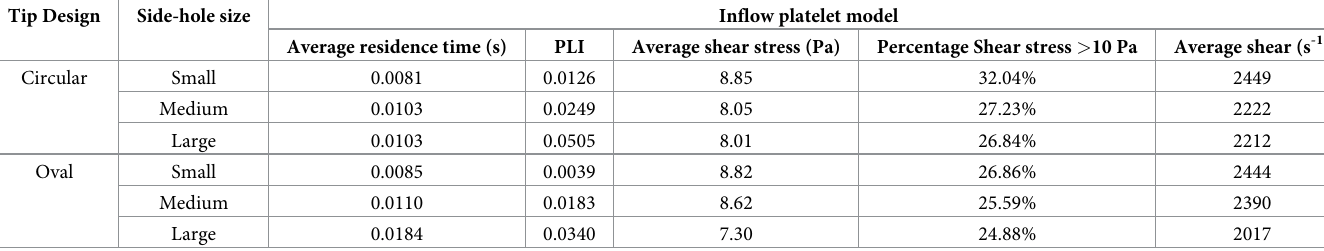
Table 3. Platelet parameters for the varying sized circular/oval